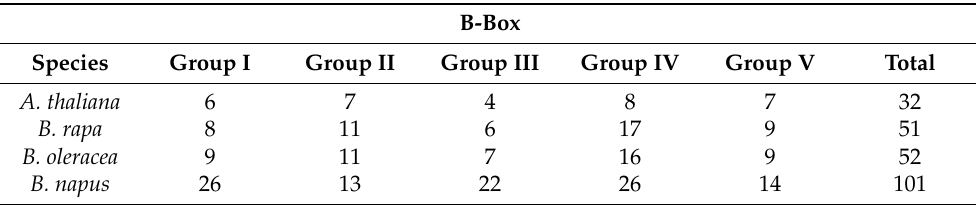
Table 1. Summary of B-box genes in B. rapa , B. oleracea , B. napus and Arabidopsis thaliana